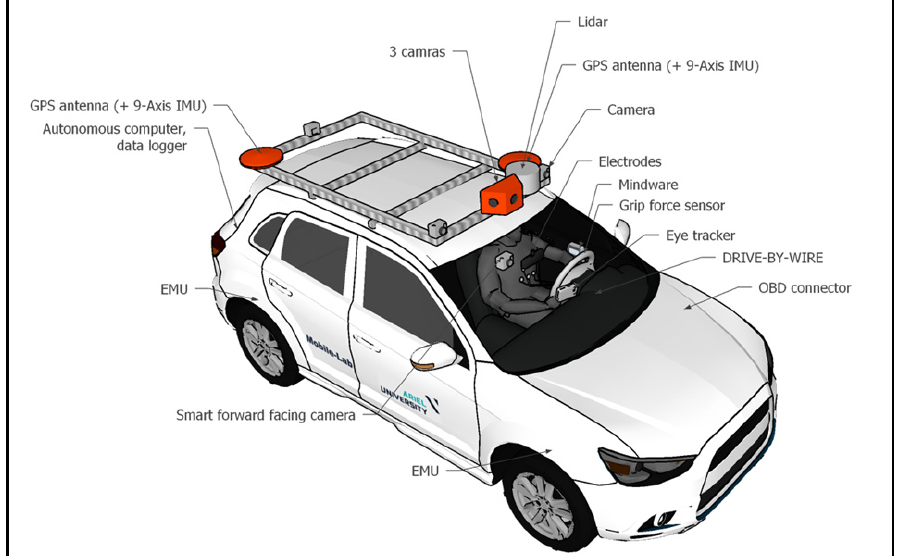
Figure 2. Ariel University’s Mobile-Lab, used in the current research as the remotely controlled vehicle, is equipped with a three-camera set transmitting the live video to the remote driving station, as well as a remote driving system.